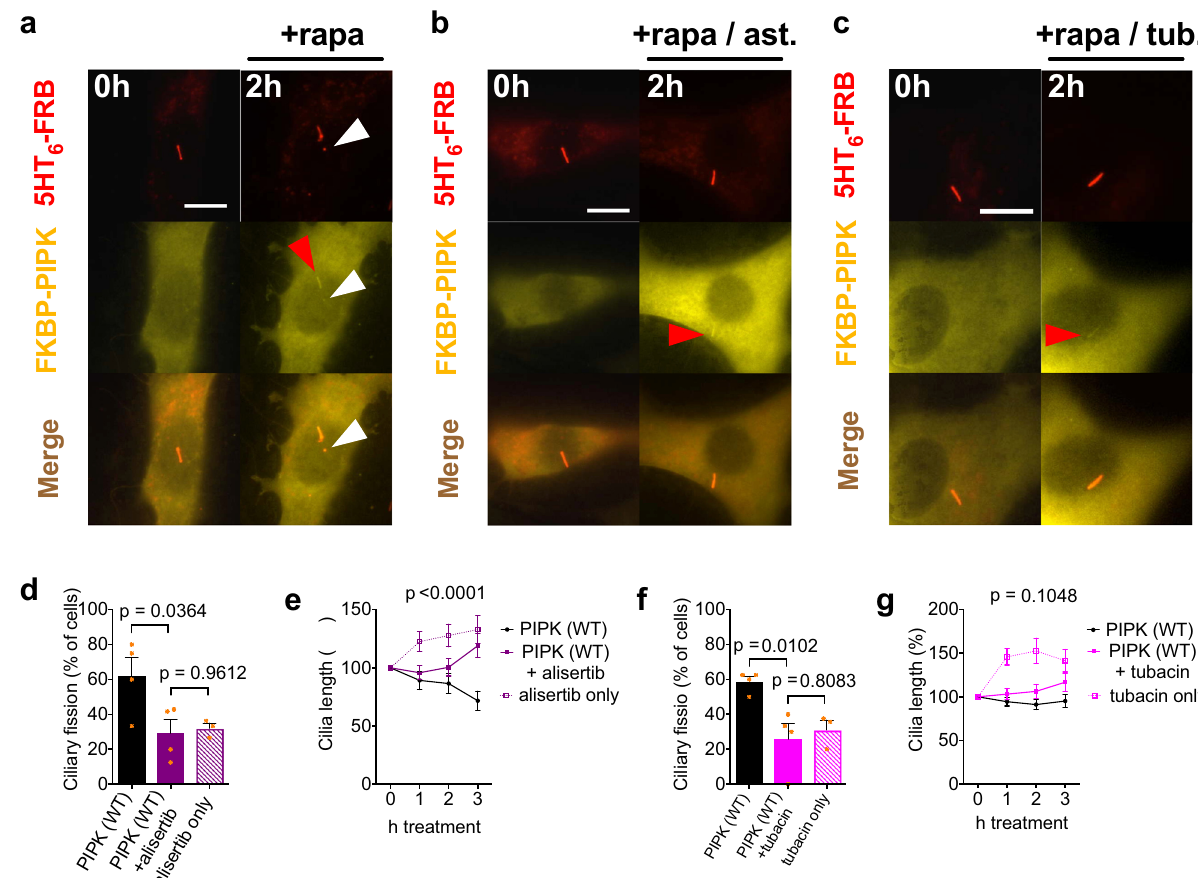
Fig. 3 Ciliary fi ssion requires Aurora Kinase A. a – c Time-lapse images of NIH3T3 cells expressing the ciliary marker 5HT 6 -mCherry-FRB and the CID tool YFP-FKBP-PIPK acquired 0 and 2 h after addition of rapamycin (100 nM fi nal) and in addition alisertib (200 nM fi nal, b ), tubacin (20 µ M fi nal, c ) or control (DMSO, a ). White arrowheads mark ciliary vesicles. Red arrowheads mark recruitment of PIPK. Scale bars 10 µ m. d Frequency of ciliary fi ssion in n = 3 – 4 independent experiments with cells treated as in ( a ), ( b ) and Supplementary Fig. S4h. One-way ANOVA: p < 0.0402, results of posthoc tests are depicted. e Normalized cilium length in the same n = 35, n = 28 and n = 41 cells as in ( d ). Two-way ANOVA was used to compare PIPK (WT) and PIPK WT + alisertib, p -value for the interaction between factors treatment and time is depicted. There was no signi fi cant difference between PIPK (WT) + alisertib and alisertib only (two-way ANOVA, p = 0.0677). f Frequency of ciliary fi ssion in n = 3 – 4 independent experiments with cells treated